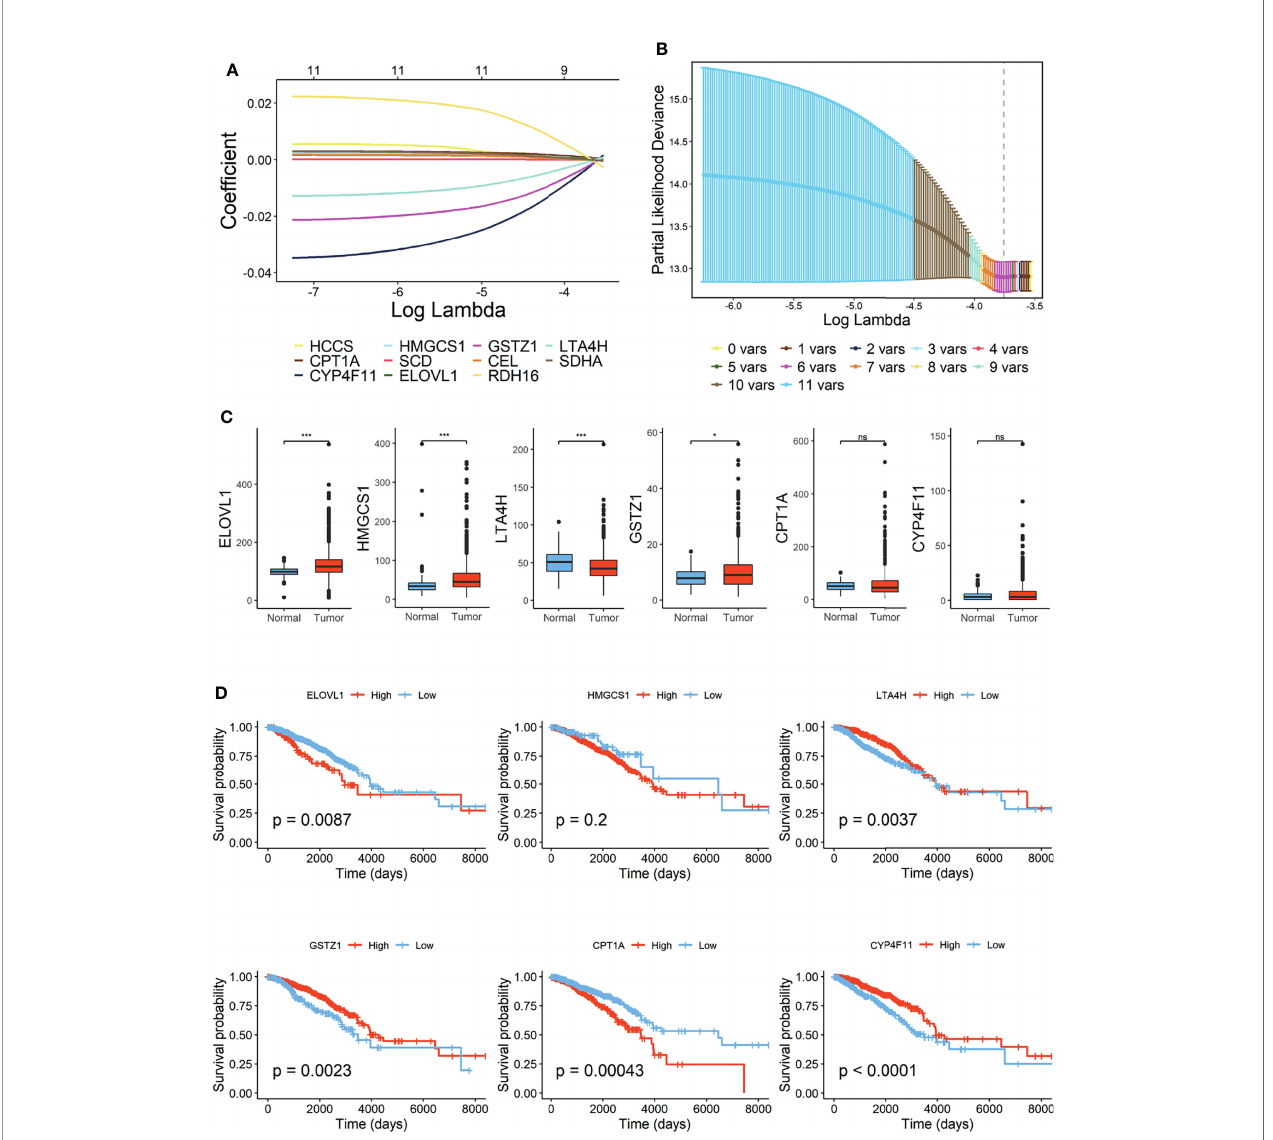
FIGURE 2 | Construction of fatty acid metabolism-related signature in TCGA-BRCA cohort. (A) Lasso Cox regression analysis. (B) Partial likelihood deviance for the Lasso regression. (C) Expression level of 6 FMGs contained in signature. (D) Kaplan – Meier (K-M) analyses of OS based on expression level of 6 FMGs. TCGA, The Cancer Genome Atlas; FMGs, fatty acid metabolism-related genes; OS, overall survival. *Means p < 0.05; *** means p < 0.001; ns means no signi fi